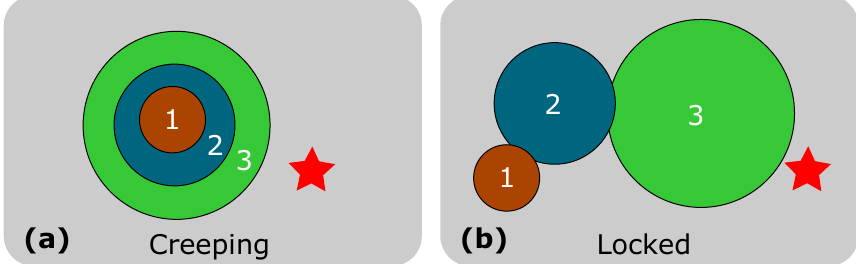
Figure 4. Schematic illustration of the hypothetical nucleation models. ( a ) Aseismic triggering hypothesis [9]. ( b ) Accelerated and migratory triggering hypothesis. In both ( a , b ), colored circles represent the seismic precursors; red star marks the nucleation point of the landslide.